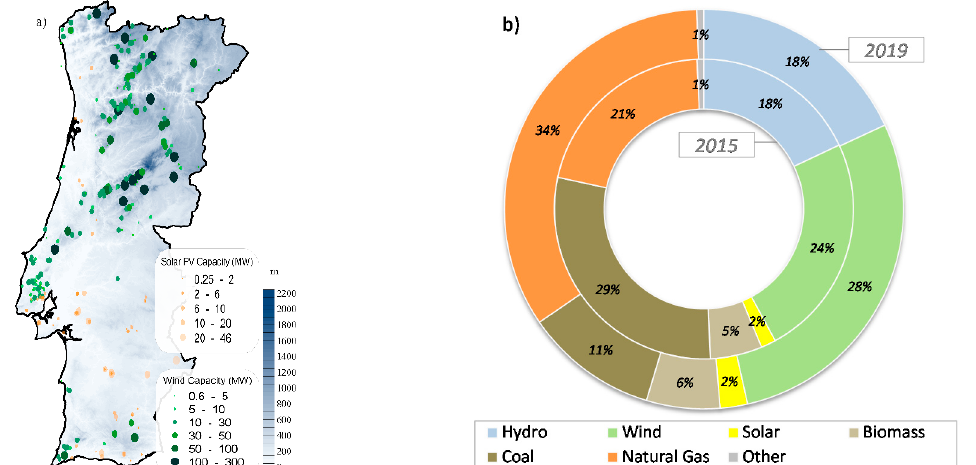
Figure 2. Portuguese power system characterization at the end of 2015: ( a ) spatial distribution of the wind and solar photovoltaic (PV) power capacity, and ( b ) energy contribution from the different sources during 2015 (reference year) and 2019.